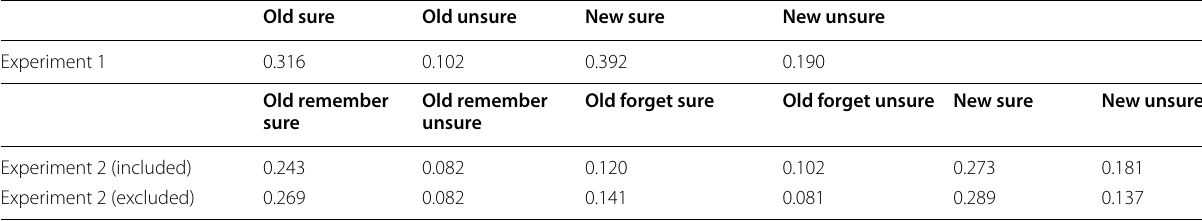
Table 1 Proportion of trials in which participants pressed each of the four possible responses in the test phase of Experiment 1 (Old Sure, Old Unsure, New Sure, New Unsure) and each of the six possible responses in Experiment 2 (Old Remember Sure, Old Remember Unsure, Old Forget Sure, Old Forget Unsure, New Sure, New Unsure). Experiment 2 is separated by the 84 participants who are included in the primary analyses (denoted Experiment 2 (Included)) and the 76 participants who were excluded from the primary analyses based on post-experimental survey responses (denoted Experiment 2 (Excluded))